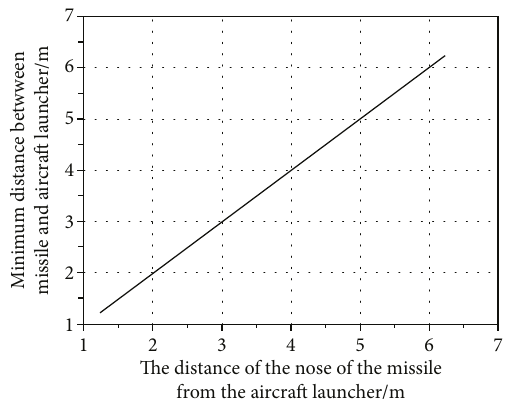
Figure 31: Minimum distance between missile and aircraft ’ s